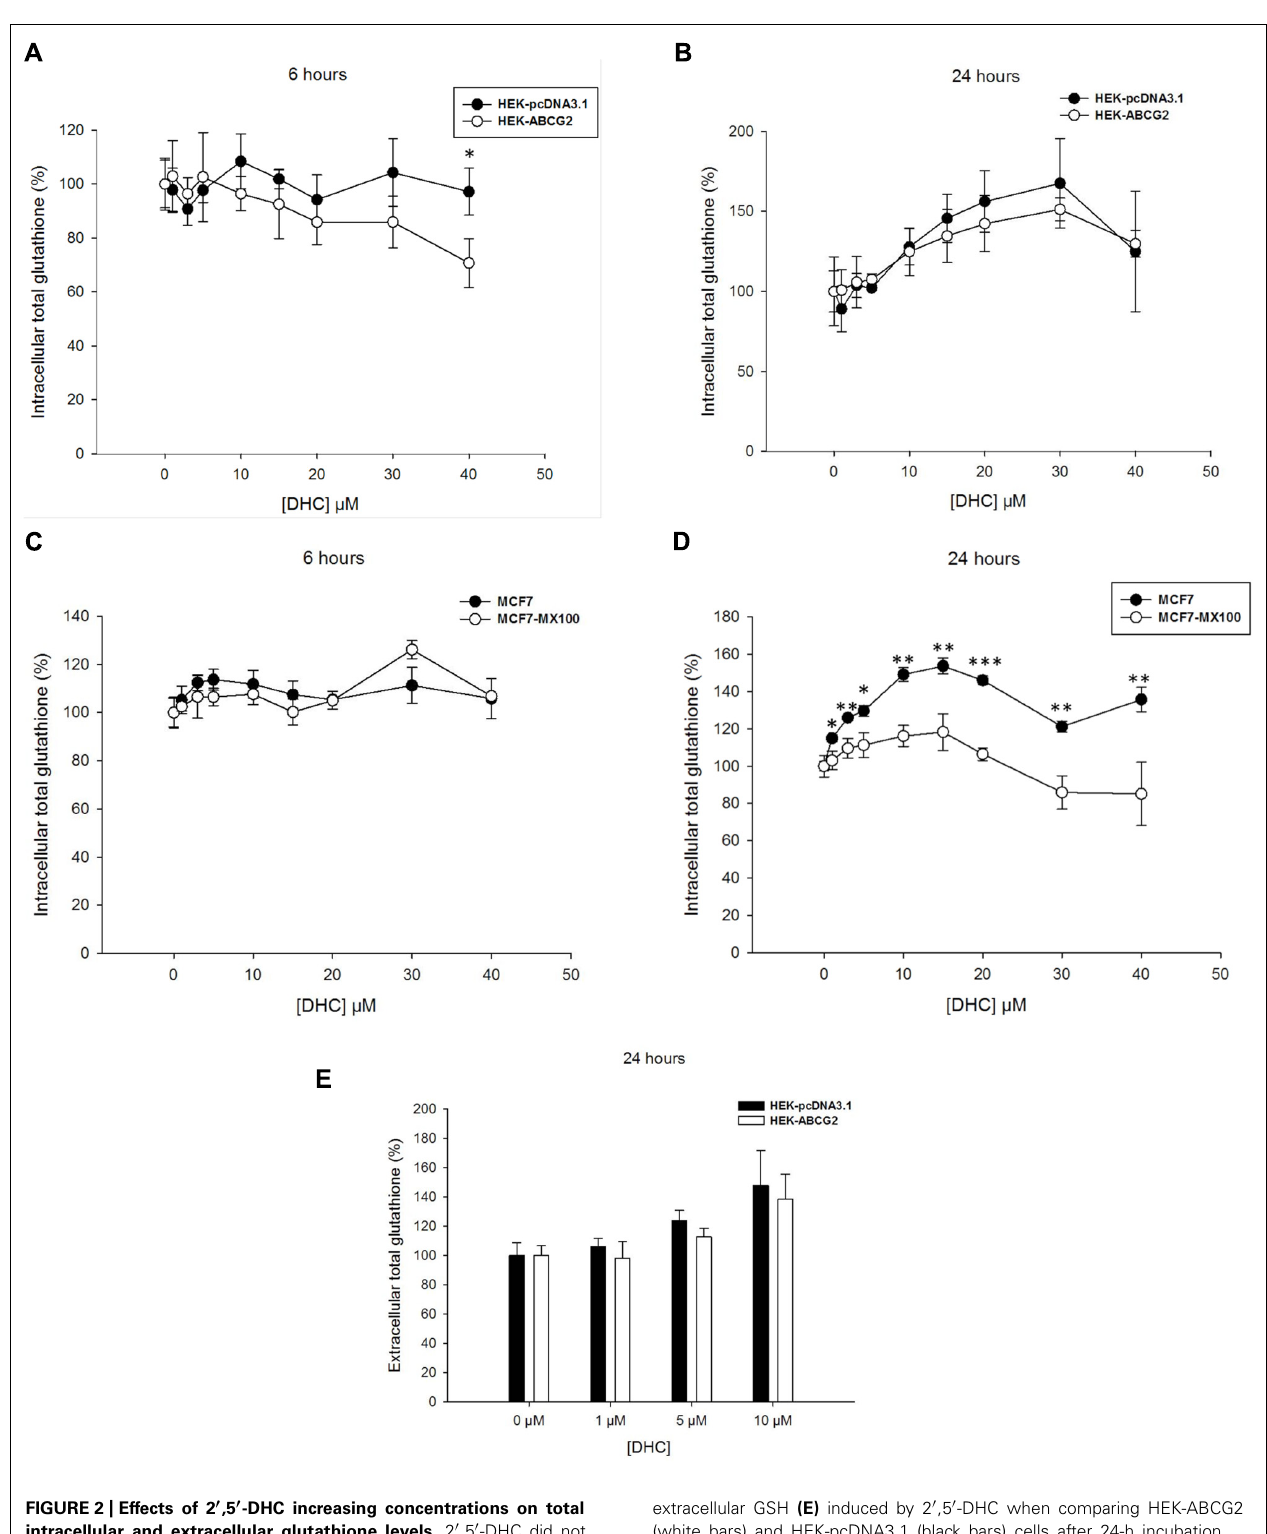
FIGURE 2 | Effects of 2 (cid:2) ,5 (cid:2) -DHC increasing concentrations on total intracellular and extracellular glutathione levels. 2 (cid:2) ,5 (cid:2) -DHC did not induce intracellular GSH depletion in ABCG2 cells (white circles) by comparison to control cells (black circles) in either HEK293 transfected cells during 6 (A) or 24 h (B) , or MCF7 cancer cells during 6 (C) or 24 h (D) . Moreover, there was no net ABCG2-dependent increase in